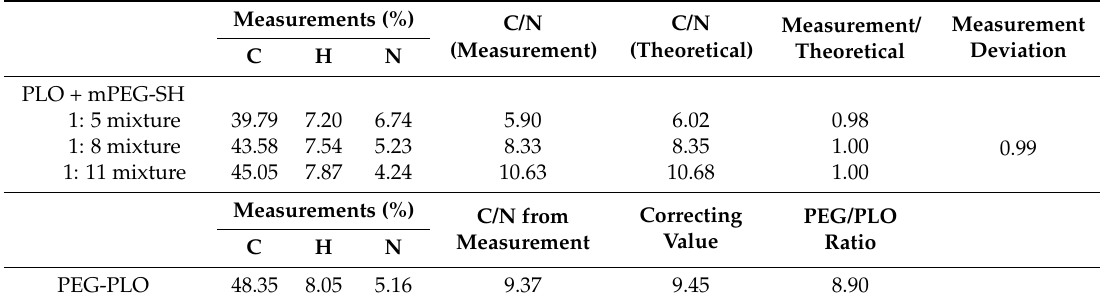
Table 1. Measurement values and carbon-to-nitrogen (C/N) ratio of PEG-PLO by elemental analysis.